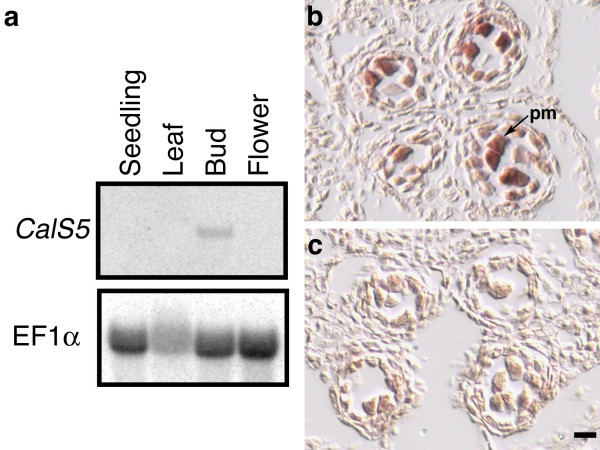
CALS5 is expressed in mature pollen and pollen mother cells. Northern blot of mRNA isolated from various tissues and probed with CALS5 and EF1α (a). In situ hybridization of pollen mother cells (pm) within sectioned anthers (b-c); CALS5 anti- sense (b) and sense probe (c). Bar, 100 μm.